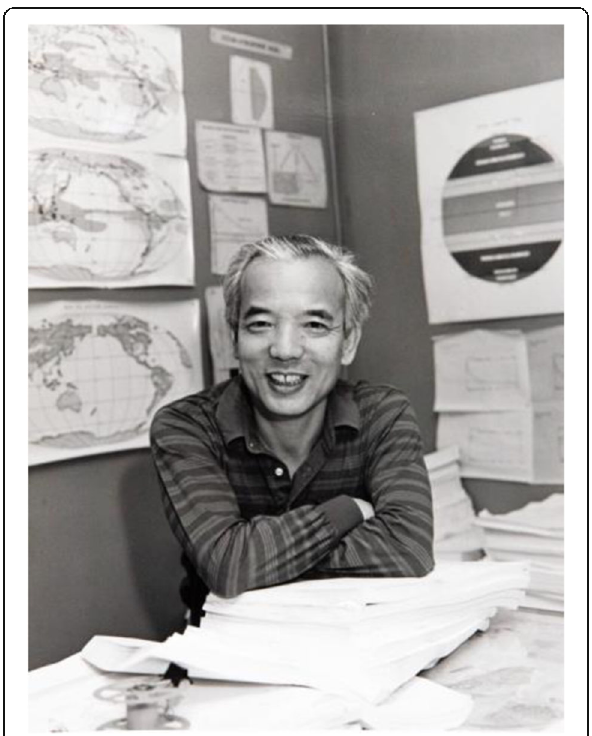
Fig. 14 Prof. Syukuro Manabe in 1997 at Princeton University (Photo by Princeton University, Office of Communications, Robert P.